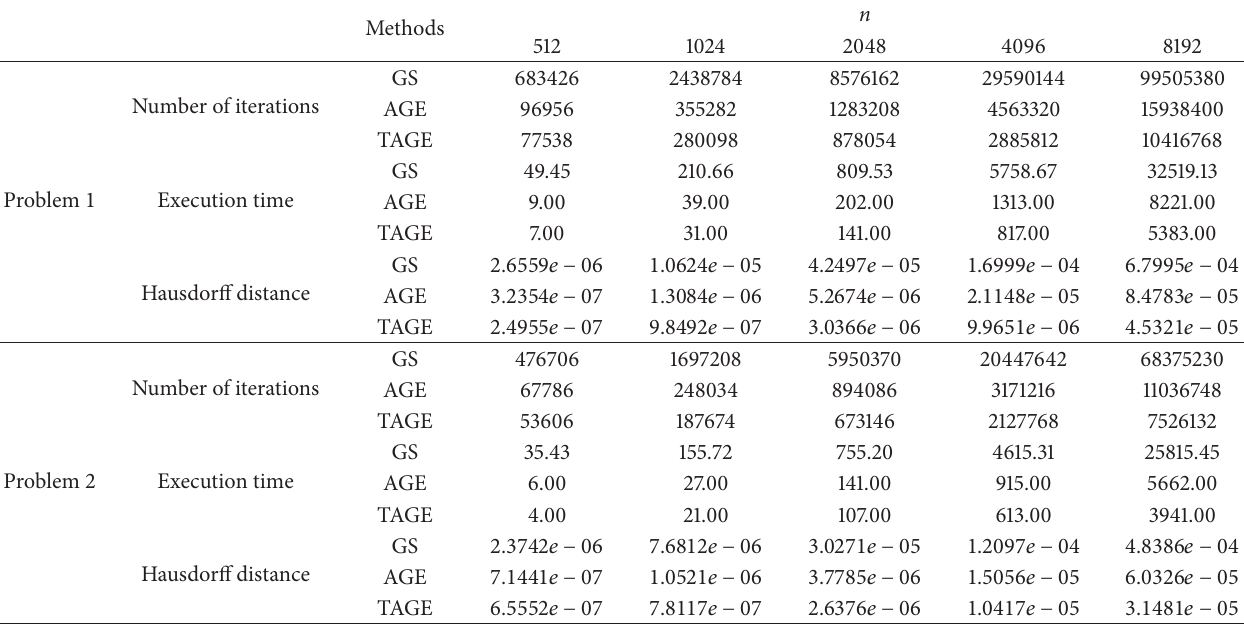
Table 5: Comparison of three parameters between GS, AGE, and TAGE methods at 𝛼 = 1 .